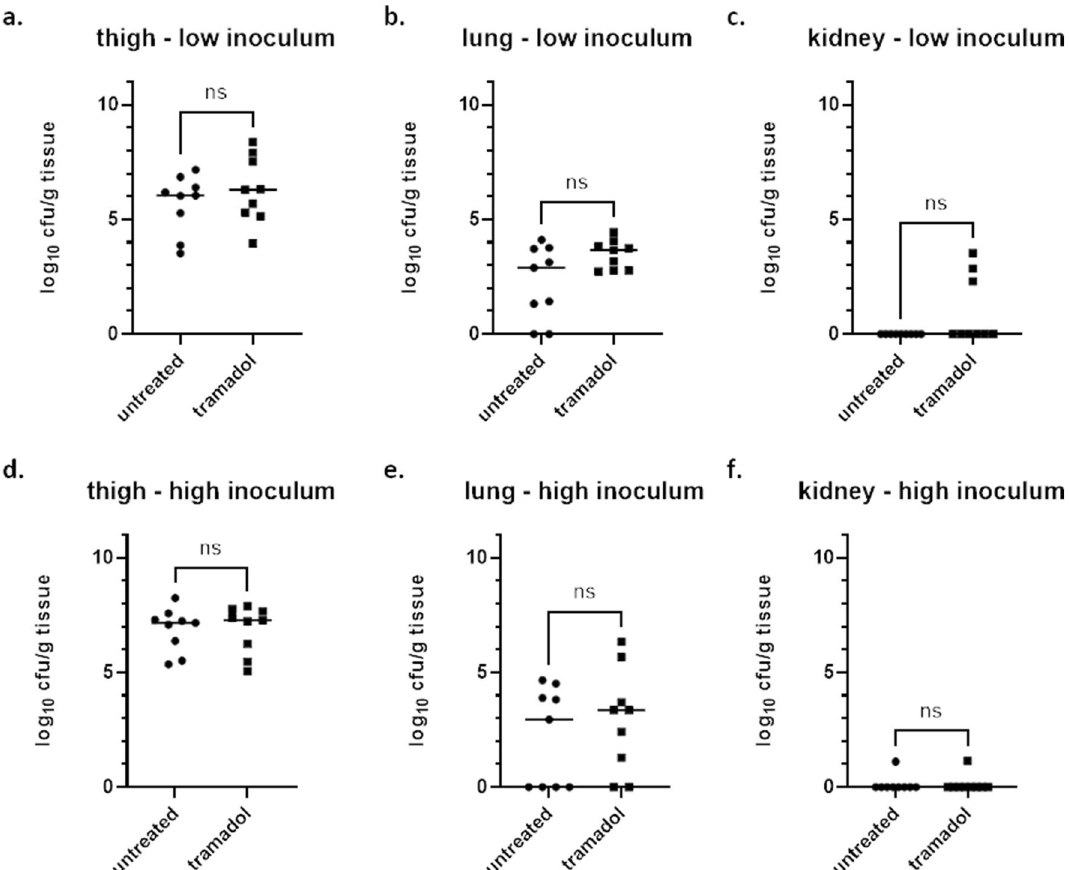
Figure 1. Bacterial burden in untreated and tramadol-treated groups in the neutropenic thigh infection model with two different inocula of E. faecalis . Bacterial burden expressed as cfu/g tissue was assessed for groups that were treated with either 20 mg/kg tramadol subcutaneously or left untreated (n = 9 per group). All groups were infected with E. faecalis at a low inoculum (1 × 10 7 cfu/ml, a - c ) or at a high inoculum (1 × 10 8 cfu/ml, d - f ). Bacterial burden was assessed in thigh ( a,d ), lung ( b,e ) and kidney ( c,f ). Statistical testing was performed using a Kolmogorov–Smirnov test. Ns not significant.